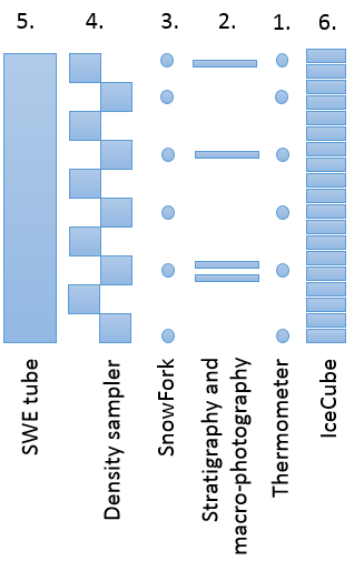
Figure 4. Snow pit measurements have been made with this plan since 2015. Measurements are made in numbered